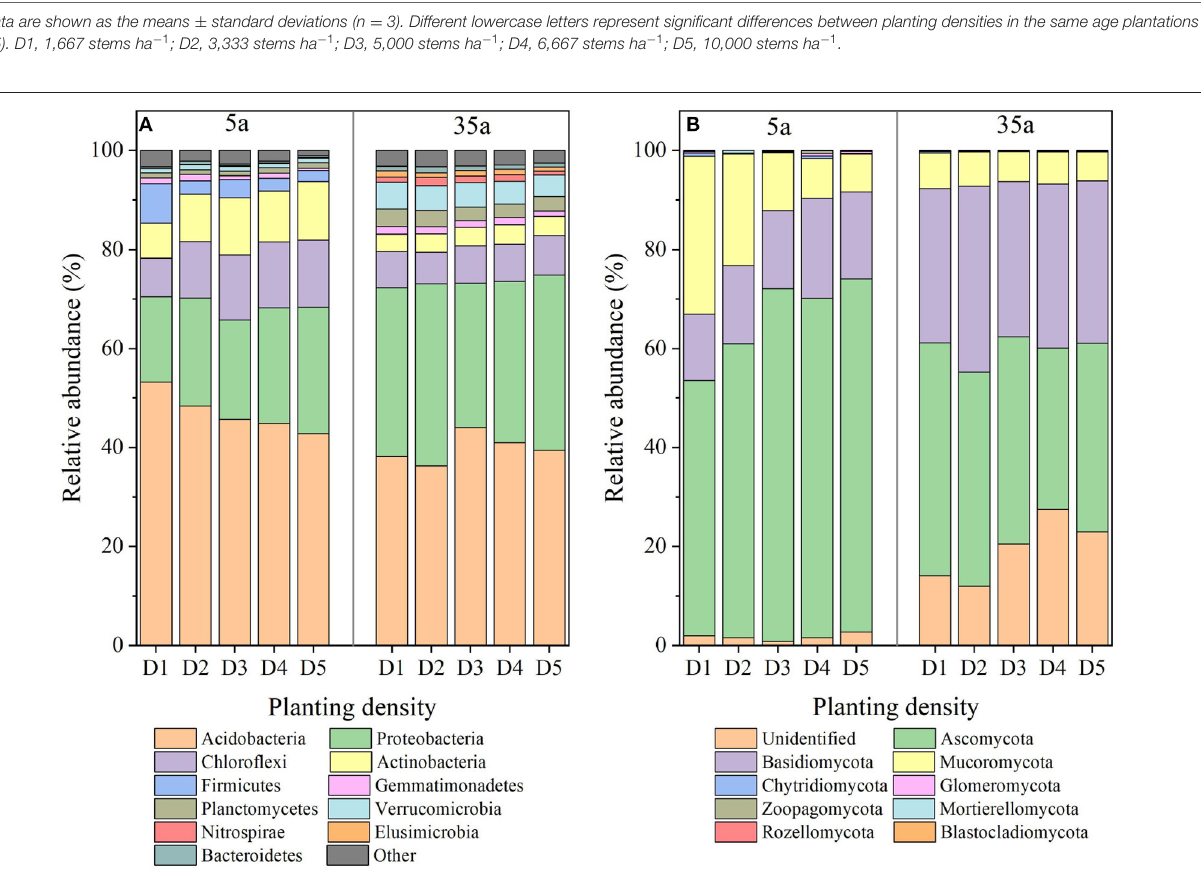
FIGURE 3 | Bacterial (A) and fungal (B) community patterns in 5-year-old (left side) and 35-year-old (right side) plantations. D1, 1,667 stems ha − 1 ; D2, 3,333 stems ha − 1 ; D3, 5,000 stems ha − 1 ; D4, 6,667 stems ha − 1 ; D5, 10,000 stems ha − 1